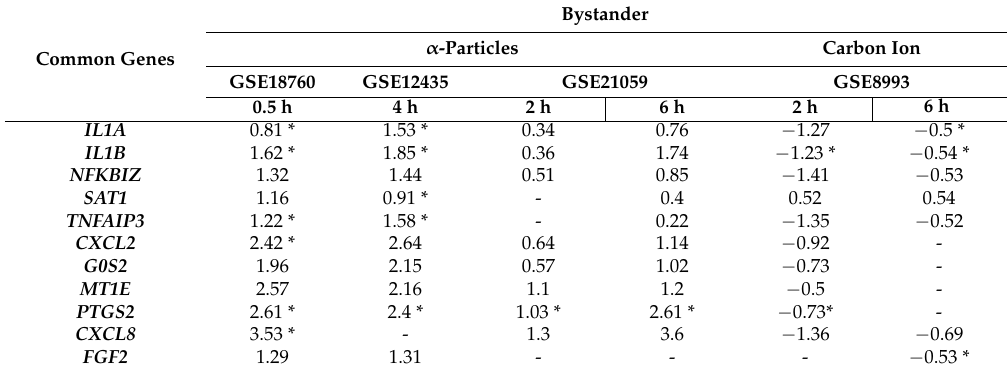
Table 7. Common DE genes resulting from all comparisons of bystander vs. control samples of the analyzed datasets. Expression values are presented as log2FC and values with * indicating genes suggested as linker genes by the GO functional enrichment analysis of